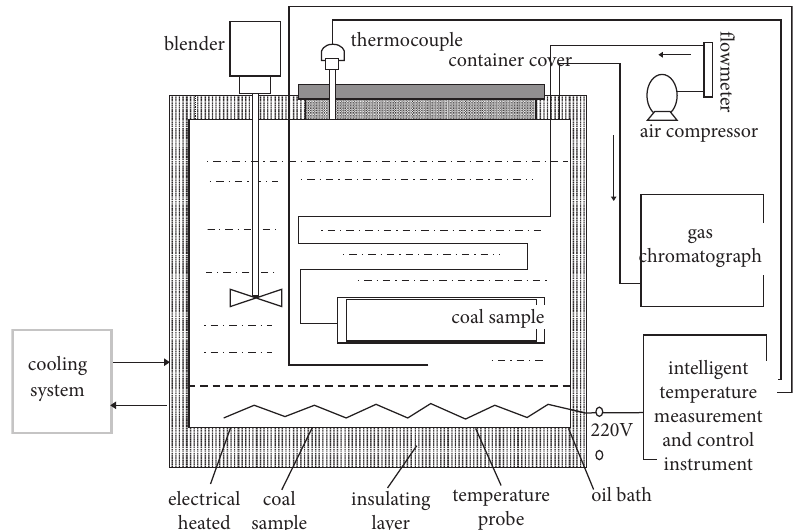
Figure 13: Schematic diagram of the temperature programmed oil bath experimental device.